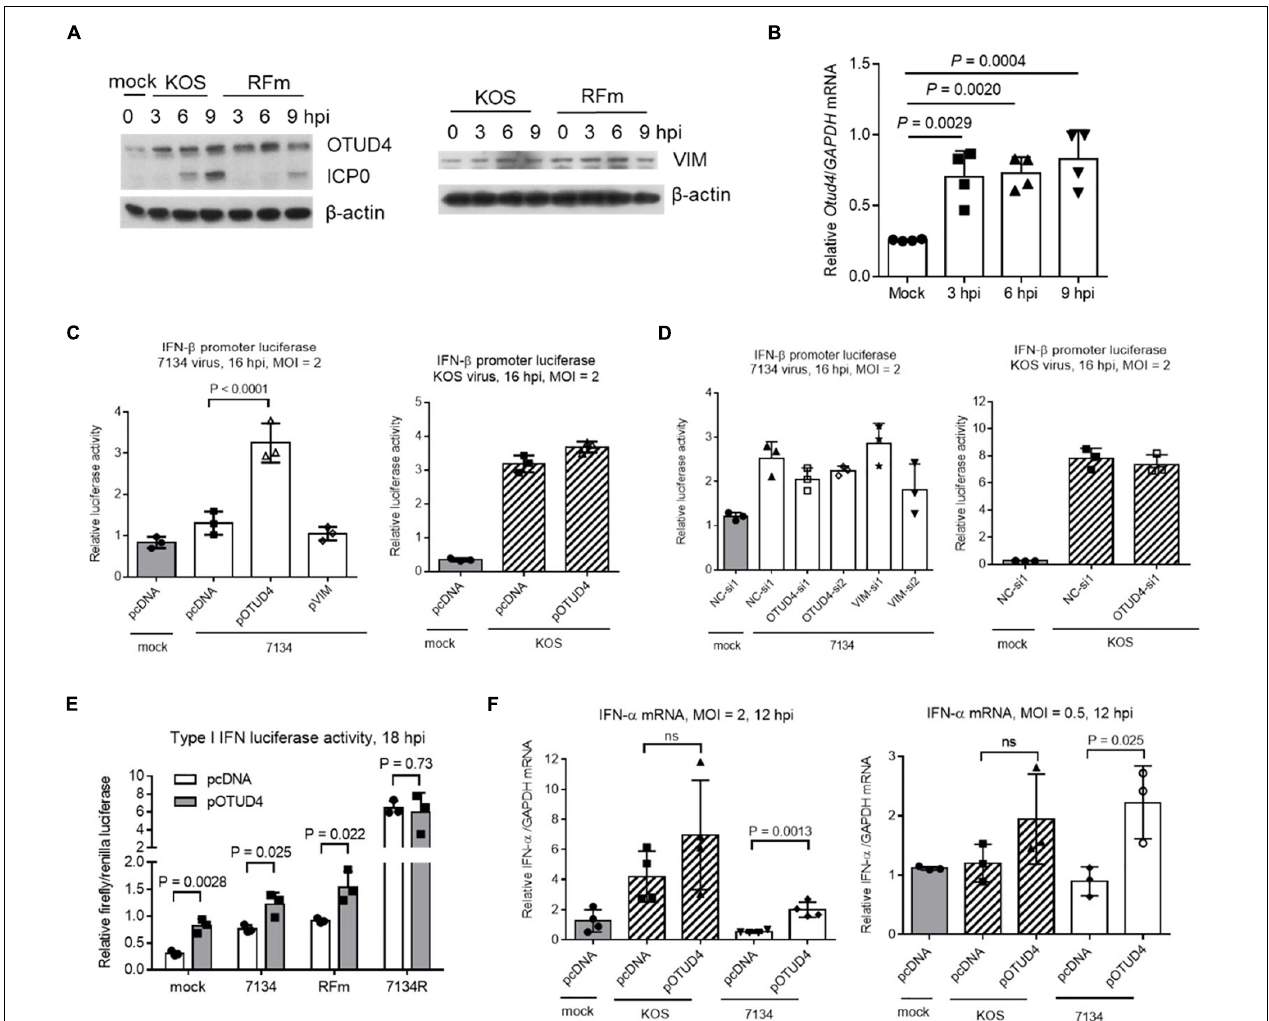
FIGURE 6 | Functions of OTUD4 and VIM in Neuro-2a cells. (A) Cells were infected with KOS or ICP0 RING finger mutant virus (RFm) at an MOI of 20 for the indicated times before the cells were harvested for Western blot analysis for the indicated proteins. (B) After infection of cells with KOS at an MOI of 20, the cells were harvested at the indicated times for qRT-PCR analysis of Otud4 mRNA levels normalized to glyceraldehyde-3 phosphate dehydrogenase (GAPDH) mRNA levels. (C) Cells were co-transfected with the indicated plasmid (400 ng/ml), pIFN- β (80 ng/ml) (an IFN- β promoter luciferase plasmid), and pRL-TK (40 ng/ml; a control plasmid expressing renilla luciferase) for 48 h and then infected with 7134 (left) or KOS (right) at an MOI of 2 for 16 h before measurement of luciferase activities. (D) Neuro-2a cells were co-transfected with the indicated siRNA (80 nM), pIFN- β (80 ng/ml), and pRL-TK (40 ng/ml) for 48 h and then infected with 7134 (left) or KOS (right) at an MOI of 2 for 16 h before measurement of luciferase activities. (E) The assay was performed as in (C) except that different viruses were used. (F) Cells were transfected with the indicated plasmid (400 ng/ml) and then infected with the indicated virus at an MOI of 2 (left) or 0.5 (right) for 12 h before qRT-PCR quantification of IFN- α mRNA normalized to GAPDH mRNA. Data were analyzed by one-way ANOVA with Dunnett’s multiple comparisons tests (B–D,F) or two-tailed unpaired t -tests (E) . Data are presented as mean values ±